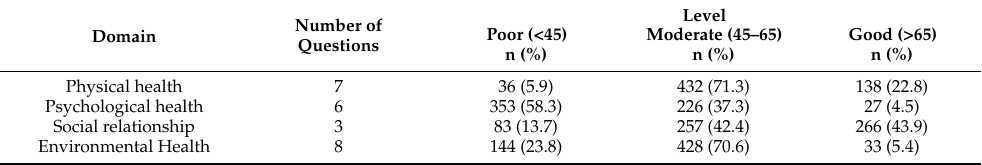
Table 4. The number of questions and level of college students’ QoL status (n = 606).